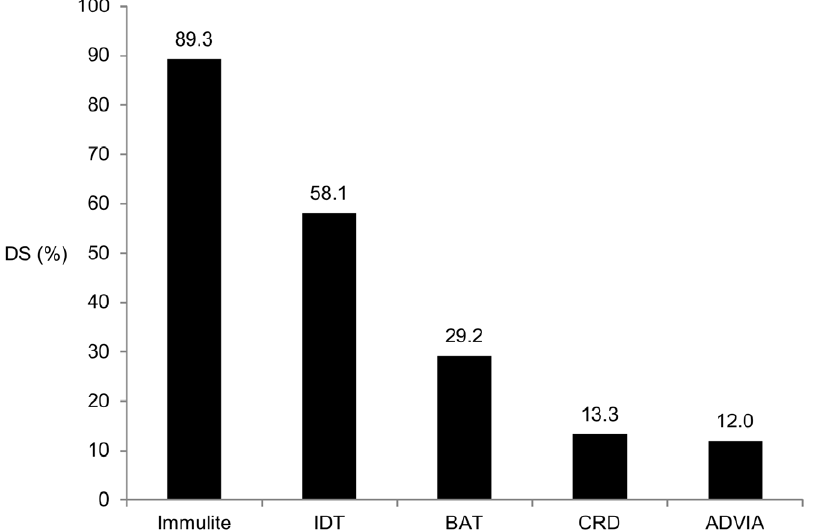
Figure 8. Double positive results in CCD-dependent double sensitization. CCD-dependent DS was verified with WB inhibition in 31 patients. The Immulite and IDT revealed the highest rates of DS in these patients (p , 0.001;